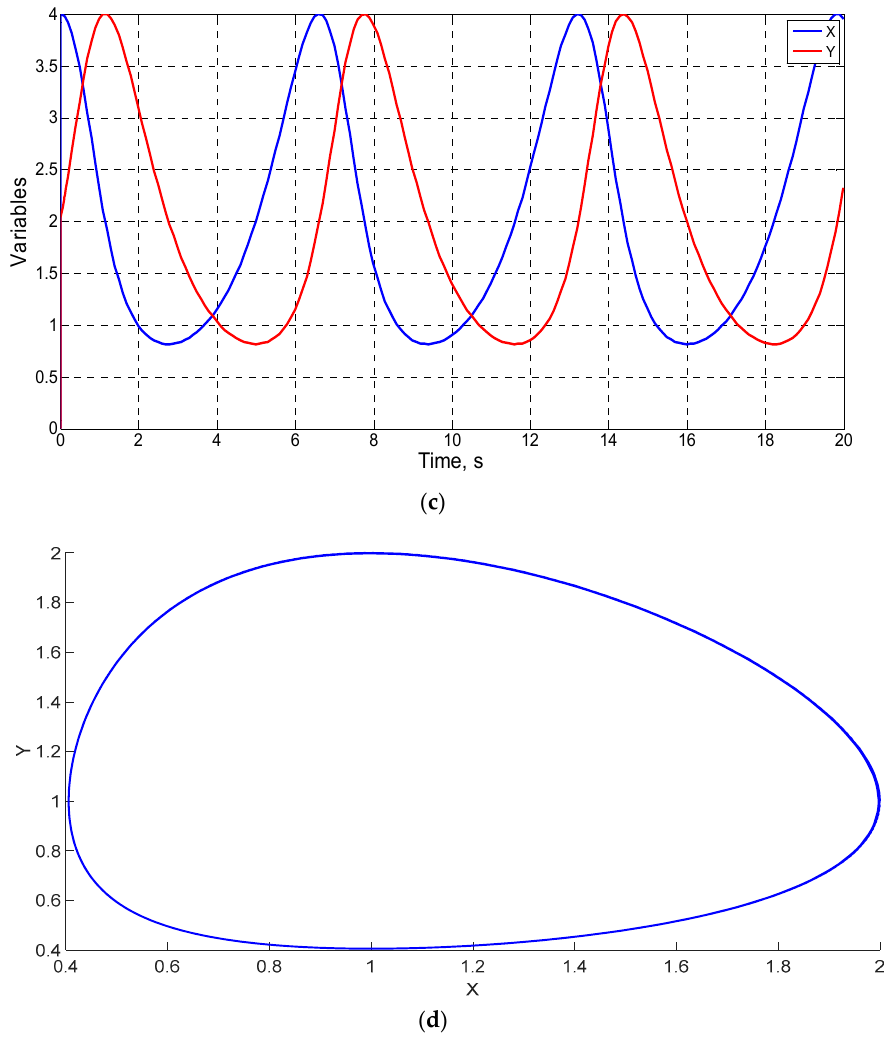
Figure 6. Concentrations of the variables x and y for case i (Table 1). ( a ) Scenario I, ( b ) Scenario II, ( c ) Scenario III, and ( d ) phase plane of scenario I.